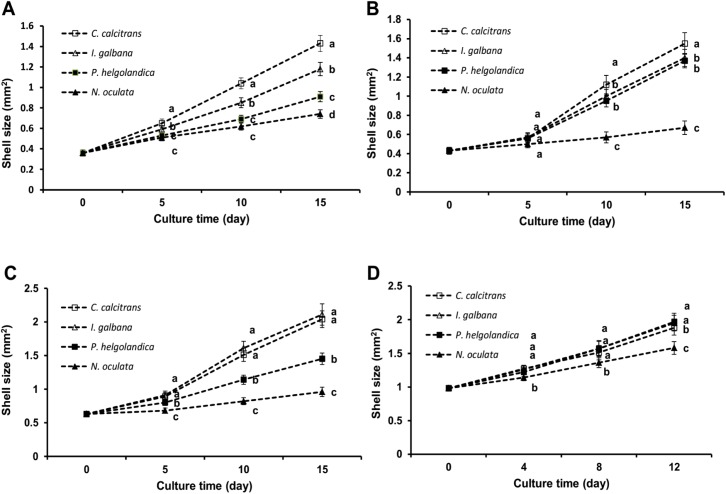
Growth of Tegillarca gransa (A), Cyclina sinensis (B), Scapharca subcrenata (C) and Sinonovacula constricta (D) fed four unialgal diets over 12 days or 15 days. The shell size is expressed as shell length × shell width (mm2). Values are expressed as the means ± SD (n = 3). Statistical significance was evaluated by one-way ANOVA, followed by the Duncan’s multiple range test. Labeled means in a column without a common letter differ, P<0.05.